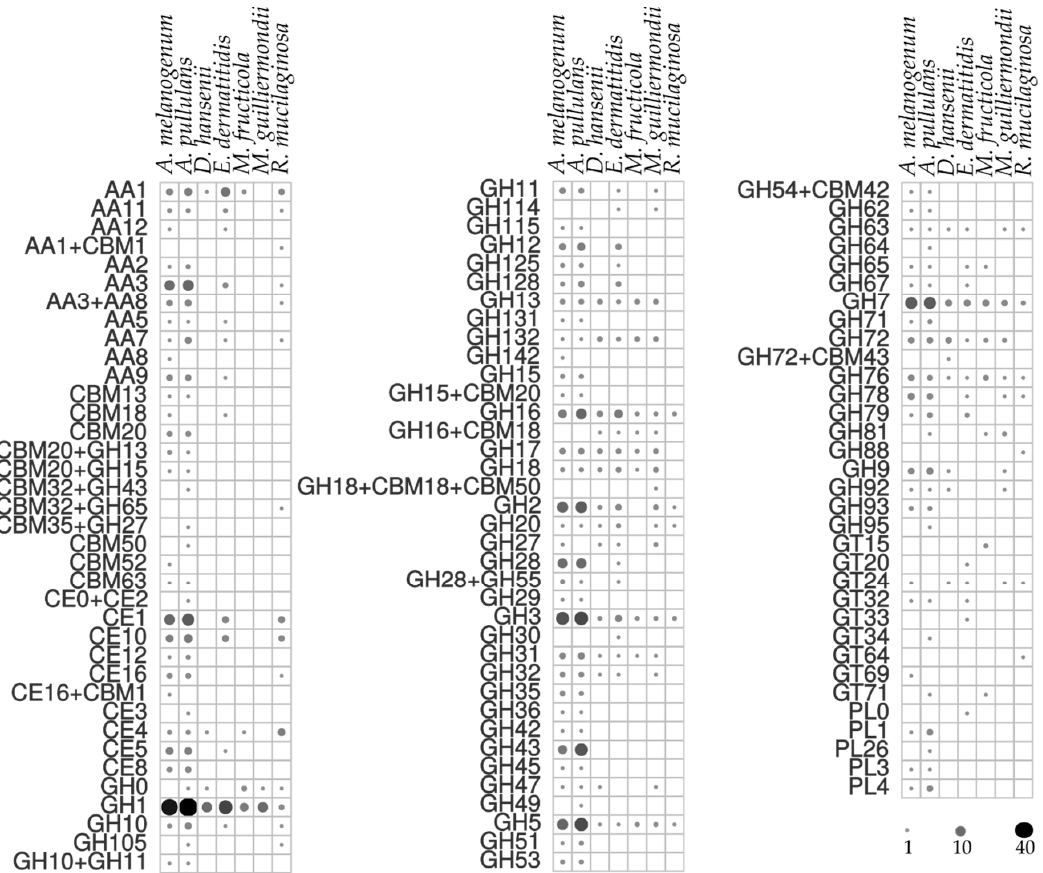
Figure 4 . Predicted numbers of carbohydrate active enzymes (CAZy) in the proteomes of the selected yeast species, according to the dbCAN server. The size and color intensity of dots corresponds to the number of homologues.